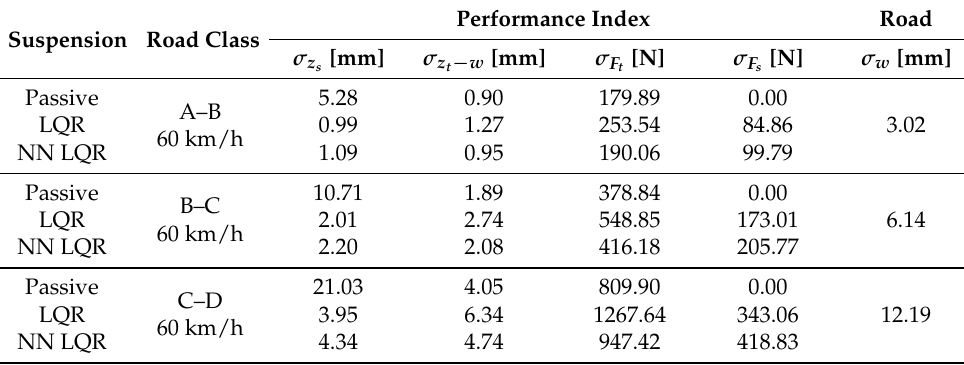
Figure 9. Time courses of the force generated by the actuator (ISO C-D, 60 km/h). Table 2. Comparison of suspension time domain performance